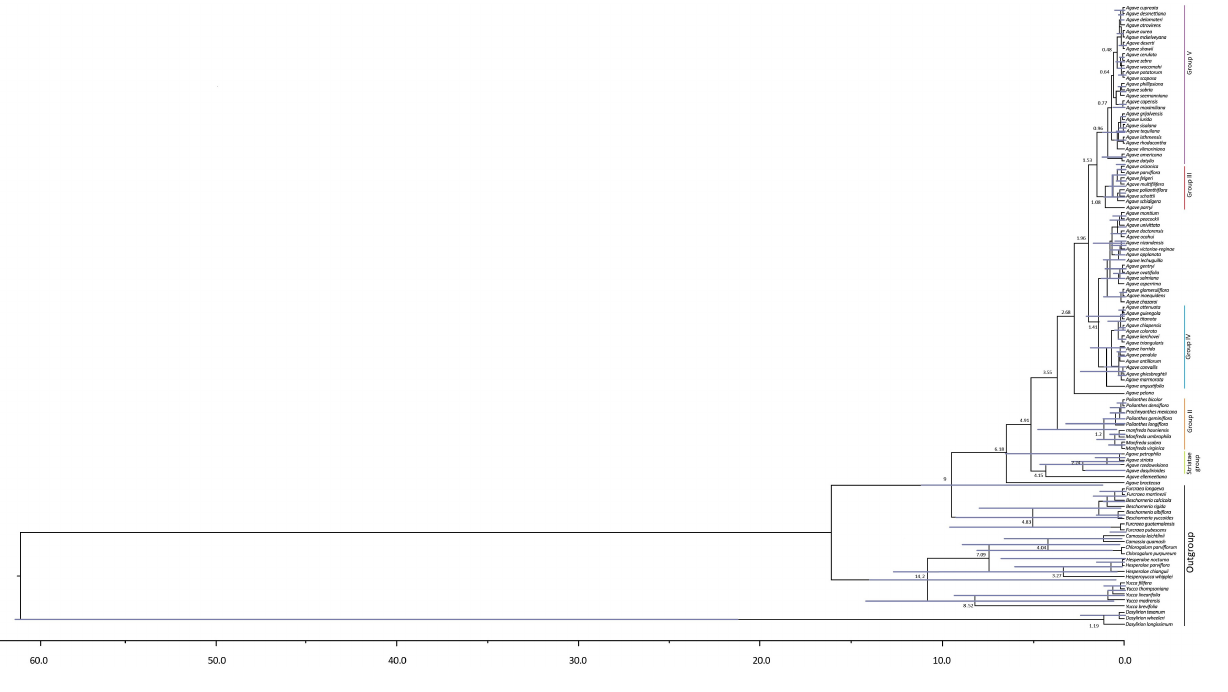
FIGURE 2 | Timing of Agave sensu lato diversification. Chronogram derived from the maximum clade credibility tree estimated with BEAST. Numbers indicate mean divergence times and mean ages, and the 95% highest posterior densities (HPD) are represented with